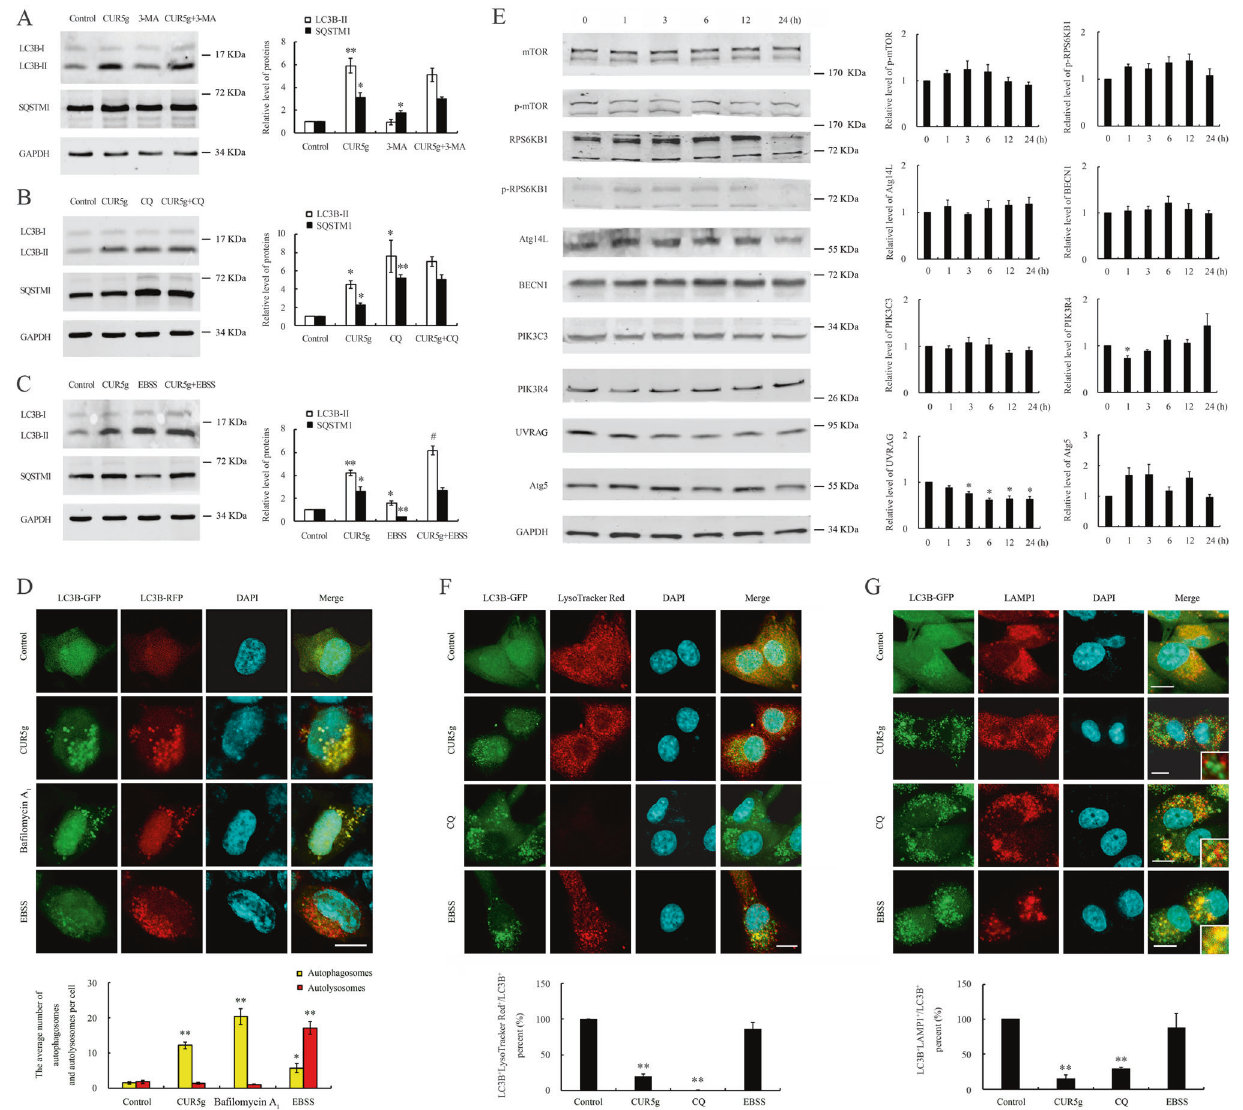
Fig. 2 CUR5g inhibits autophagosome degradation by blocking autophagosome-lysosome fusion. A Western blot analysis of LC3B-II and SQSTM1 levels in A549 cells treated with DMSO or 10 μ M CUR5g in the absence or presence of 3-MA (10 mM) for 24 h. GAPDH was used as a loading control. ( n = 3; * p < 0.05, ** p < 0.01 vs. Control). B Western blot analysis of LC3B-II and SQSTM1 levels in A549 cells treated with DMSO or 10 μ M CUR5g in the absence or presence of CQ (30 μ M) for 24 h. GAPDH was used as a loading control. ( n = 3; * p < 0.05, ** p < 0.01 vs. 0). C Western blot analysis of LC3B-II and SQSTM1 levels in A549 cells cultured in complete medium or EBSS in the absence or presence of CUR5g (10 μ M) for 24 h. GAPDH was used as a loading control. ( n = 3; * p < 0.05, ** p < 0.01 vs. 0, # p < 0.05 vs. CUR5g). D Representative fl uorescence photographs of HEK293T cells stably expressing RFP-GFP-LC3B reporter. Cells were treated with DMSO or CUR5g (10 μ M) in complete medium for 24 h, treated with EBSS for 6 h. Ba fi lomycin A 1 (100 nM)-treated cells were used as positive controls. Nuclei were stained with DAPI. Scale bar = 10 μ m. Histogram shows average number of autophagosomes (yellow) and autolysosomes (red) per cell. ( n = 3; * p < 0.05; ** p < 0.01 vs. control). E Western blot analysis of LC3B-II and SQSTM1 levels in A549 cells treated with 10 μ M CUR5g for 0 – 24 h. GAPDH was used as a loading control. ( n = 3; * p < 0.05 vs. 0). F Representative fl uorescence photographs of the colocalization of GFP-LC3B and LysoTracker Red in U87 cells treated with DMSO, CUR5g (10 μ M) for 24 h, treated with CQ (30 μ M), or incubated with EBSS for 6 h. Nuclei were stained with DAPI. Scale bar = 10 μ m. Histogram shows the percentage of LC3B + LysoTracker Red + puncta (yellow) relative to LC3B + puncta (green). ( n = 3; ** p < 0.01 vs. Control). G Representative fl uorescence images of the colocalization of GFP-LC3B and LAMP1 in U87 cells treated with DMSO, CUR5g (10 μ M) for 24 h, treated with CQ (30 μ M), or incubated with EBSS for 6 h. Nuclei were stained with DAPI. Scale bar = 10 μ m. Histogram shows the percentage of LAMP1 + LC3B + puncta (yellow) relative to LC3B + puncta (green). ( n = 3; ** p < 0.01 vs. (Fig. 2E), further ruling out the possibility that CUR5g increases target of rapamycin kinase (mTOR) and its substrate RPSK6B1, autophagy initiation. ATG14-like protein (Atg14L), BECN1, phosphatidylinositol 3-kinase The inhibition of autophagy can be induced by impaired catalytic subunit type 3 (PIK3C3), UV radiation resistance- autophagosome degradation or/and blocking of autophagosome- associated gene (UVRAG), phosphoinositide 3-kinase regulatory lysosome fusion. To clarify how CUR5g works, we detected the subunit 4 (PIK3R4), as well as ATG5. Except for the signi fi cant LC3B- LysoTracker Red colocalization within U87 cells. The overlap reduction in UVRAG levels, the levels of other proteins in CUR5g- of LC3B-GFP signals with LysoTracker Red signals was observed in treated cells were not statistically different from control cells